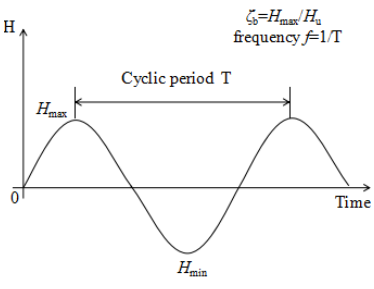
Figure 5. Loading pattern.